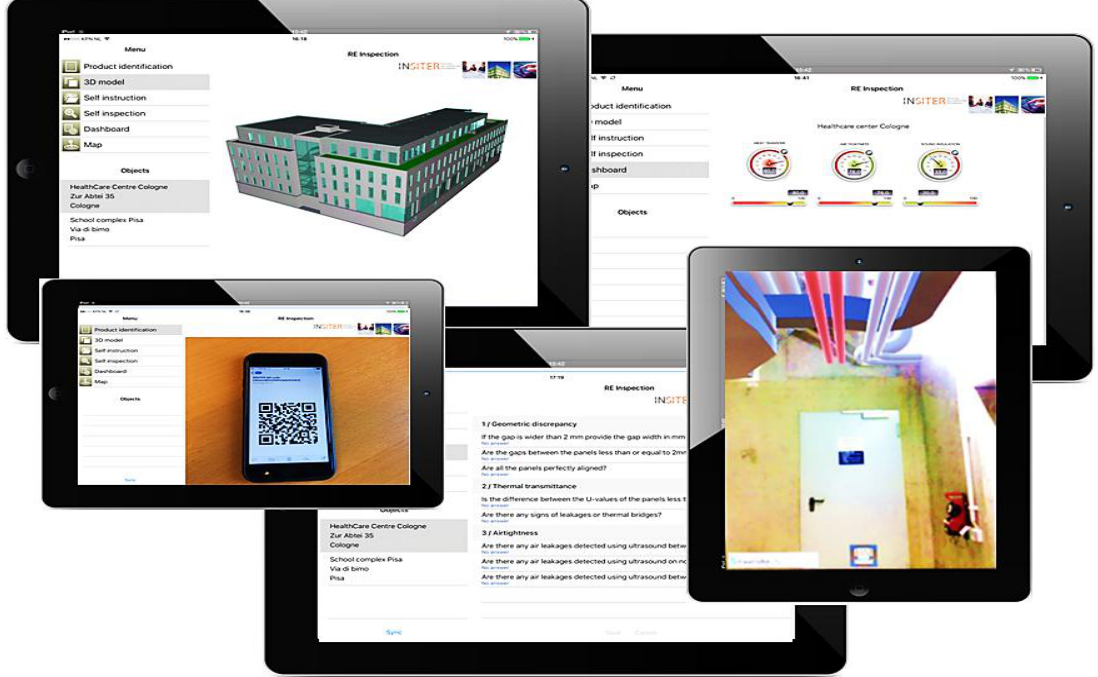
Figure 3. Self-Inspection supported by mobile inspection App.